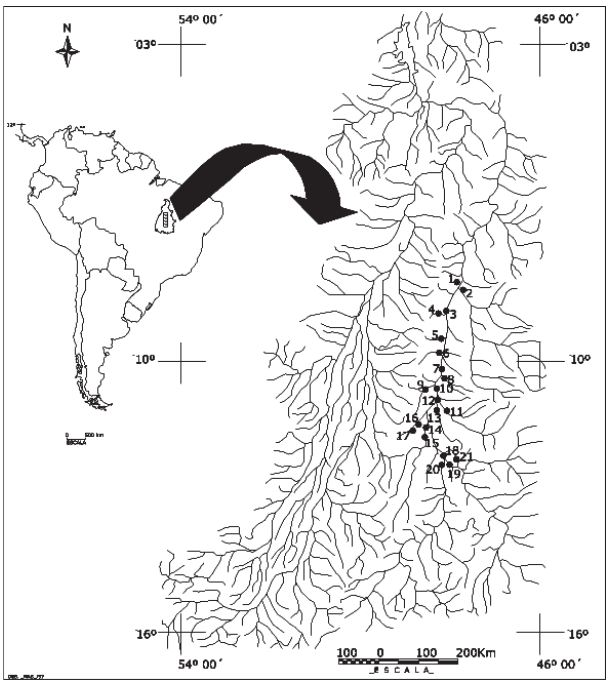
Fig. 1. Sample places location. Points number 1, 3, 7, 12, 14, 18 and 20 = Tocantins river; 2 = Sono river; 4 = Lajeadinho river; 5 = Santa Luzia river; 6 = Mangues river; 8 =